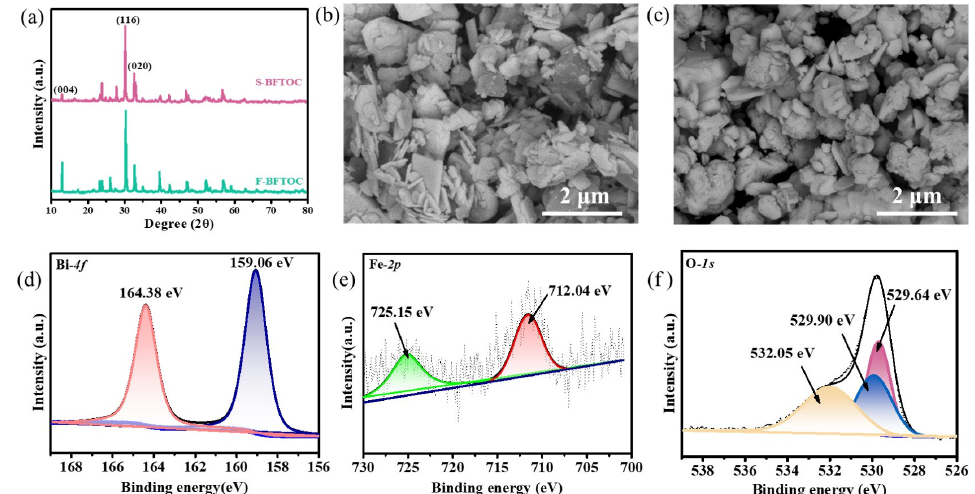
Figure 2. ( a ) XRD patterns of F-BFTOC and S-BFTOC, respectively; ( b , c ) SEM images of F-BFTOC and S-BFTOC, respectively; ( d – f ) High resolution XPS spectra of Bi-4 f , Fe-2 p , and O-1 s of F-BFTOC,